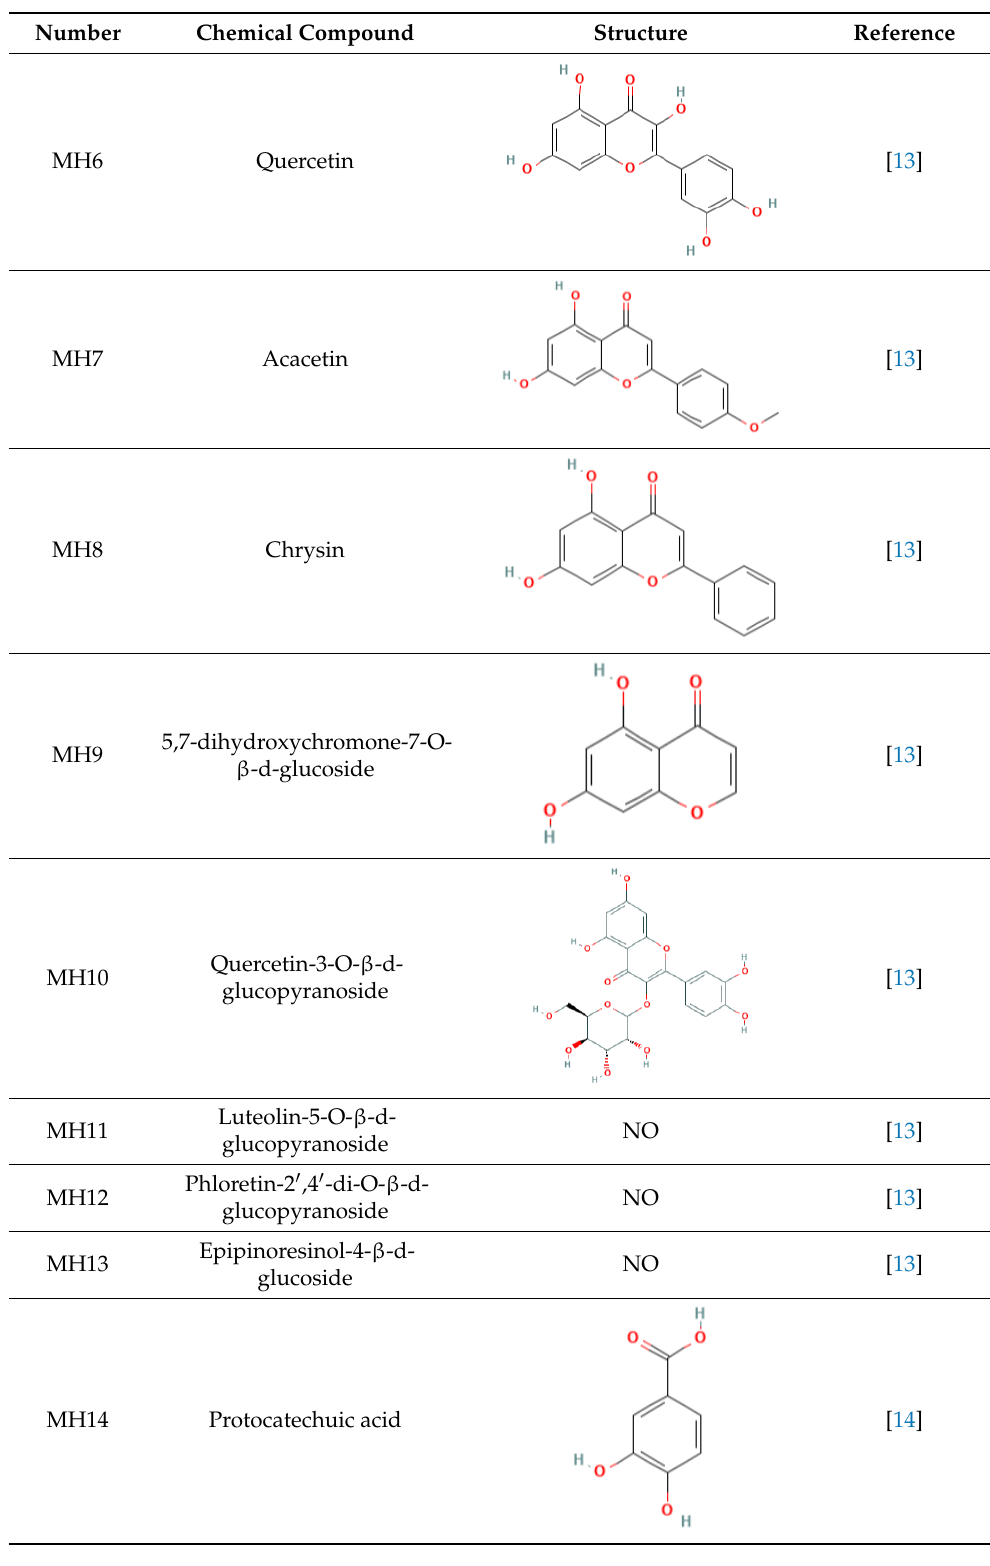
Table 1. Cont. Number Chemical Compound Structure Reference